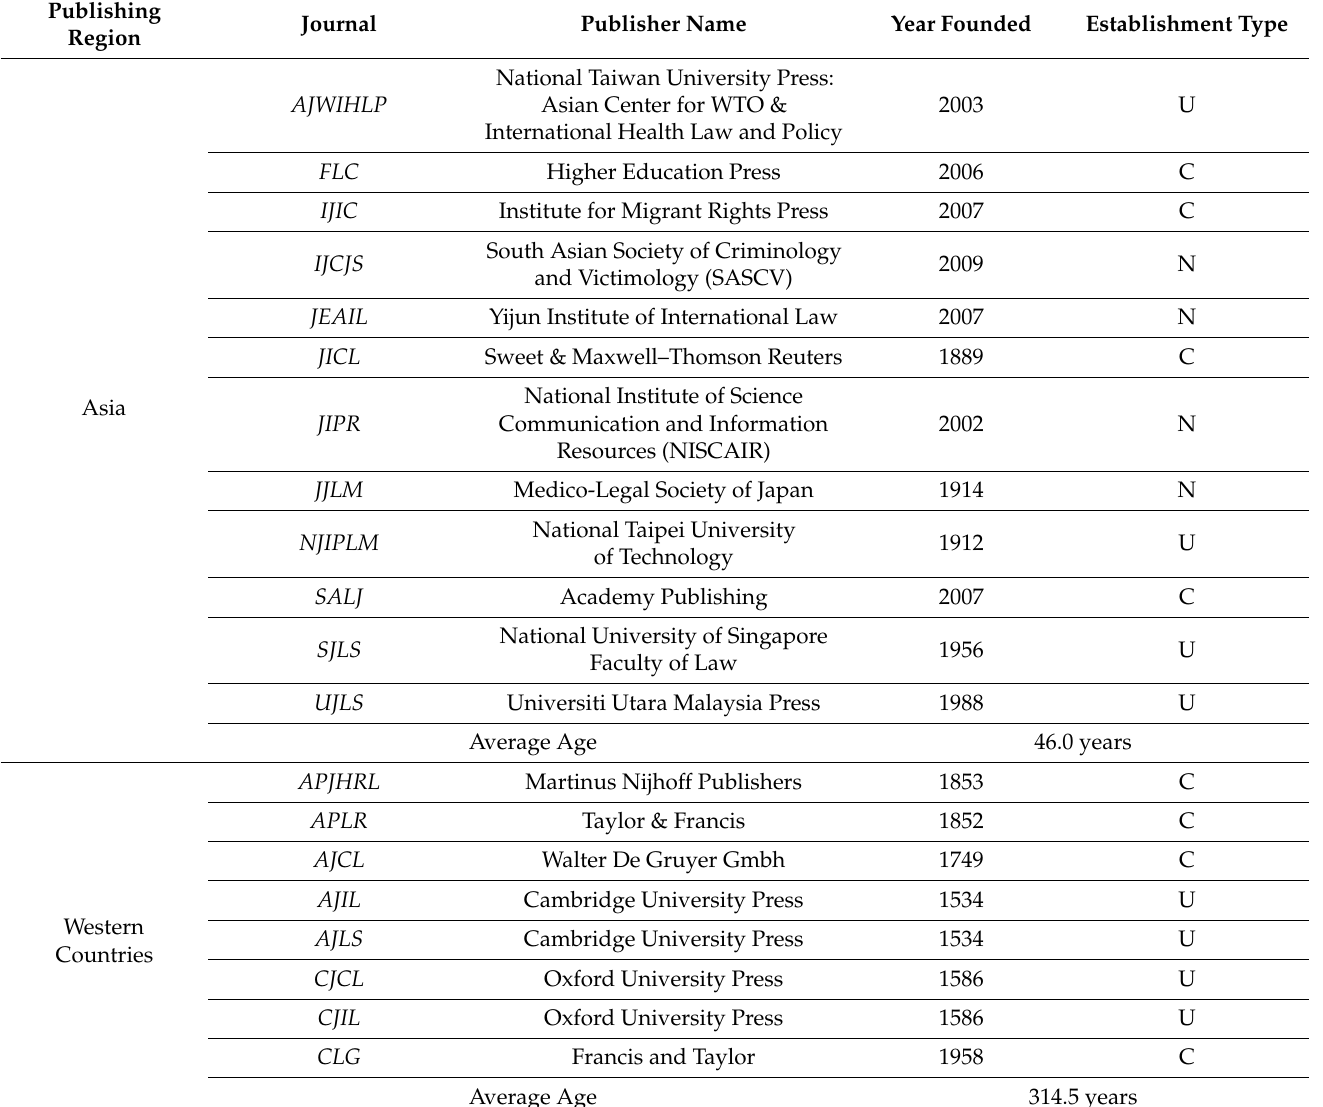
Table 3. Publishers of Asian Law